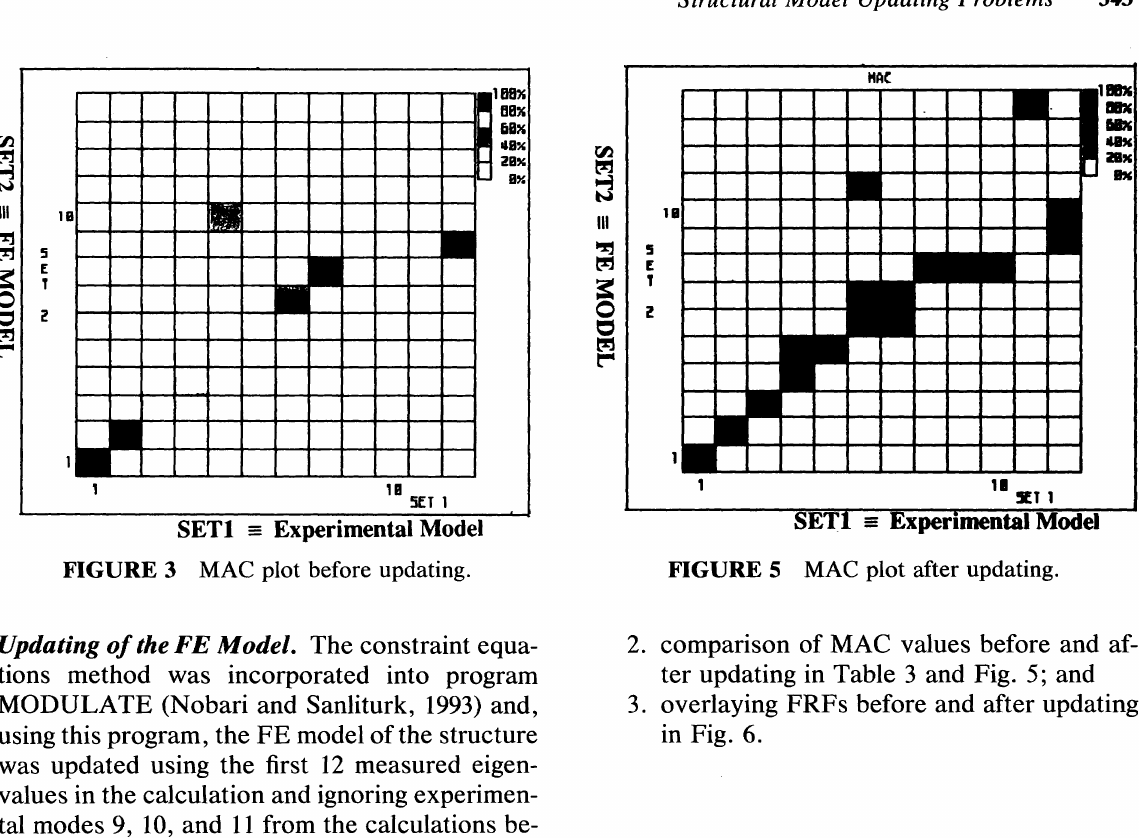
FIGURE 3 MAC plot before updating. FIGURE 5 MAC plot after updating.